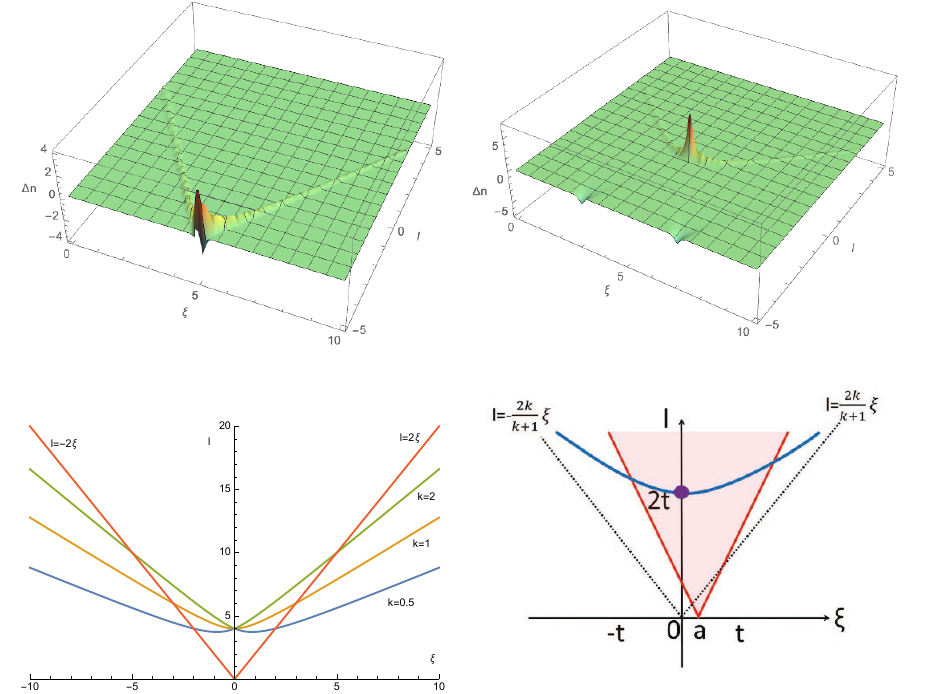
Figure 19 . The behaviors of a smeared entanglement density for the holographic joining local quench. The upper left and right graph are the plots of (cid:1) n ( (cid:24); l; t ) at t = 0 and t = 2, respectively, with (cid:11) = 0 : 1 (again we set T BCFT = 0). The horizontal and depth coordinate corresponds to (cid:24) and l , respectively. Here we smeared the originally delta functional behavior of the entanglement density by replacing the second derivatives w.r.t. l and (cid:24) with (cid:12)nite-di(cid:11)erences (cid:14) = 0 : 1. We observe a delta functional behavior on the curve (5.12) at k = 1. The lower left picture describes the curve (5.12) for k = 0 : 5 (blue), k = 1 (orange) and k = 2 (green) at t = 2 as well as the line l = 2 j (cid:24) j (red). The lower right picture shows the computation of S A for a (cid:28) t (cid:28) b by integrating the ED over the red region. The blue curve represents the peaks on (4.19). As the time evolves, the blue curve enters into the red region from both the left and right side. This explains the logarithmic growth of EE with the doubled